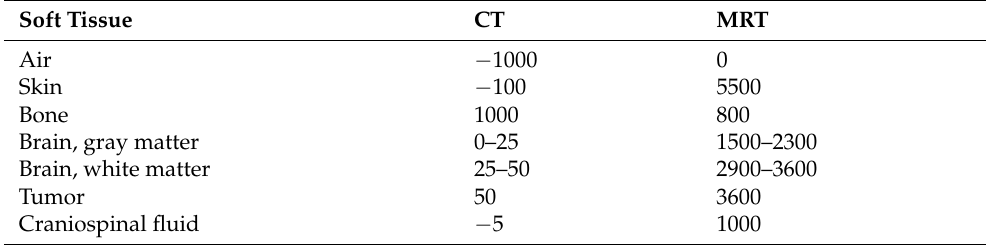
Table A1. Voxel intensities assumed in the CT (Hounsfield units) und MRT implementations of the Shepp–Logan